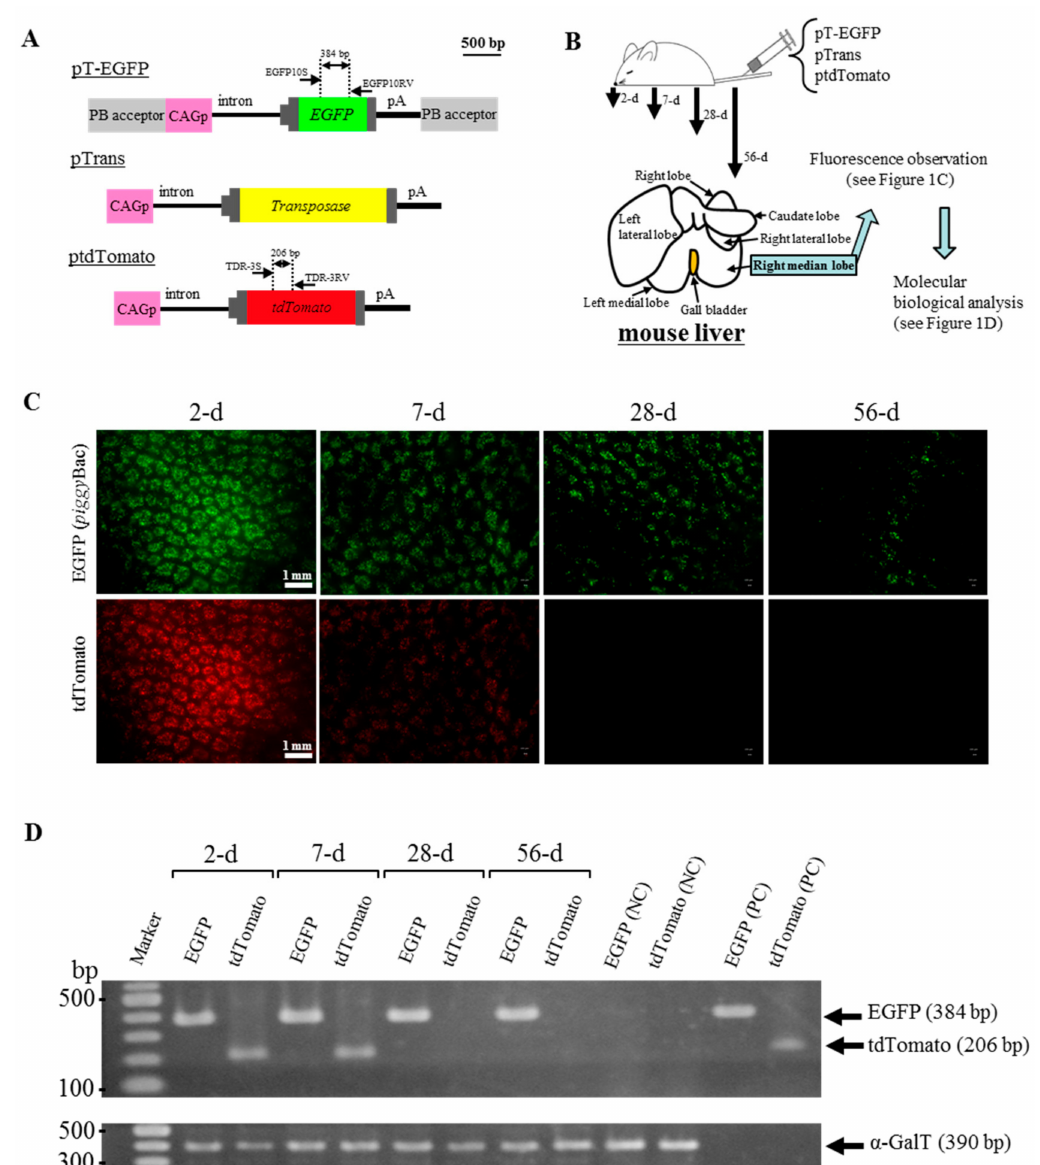
Figure 1. Hydrodynamics-based gene delivery and PB transposon system enable long-term gene expression in murine liver. ( A ) Structure of plasmid vectors used. The position of primers is shown above each plasmid. CAG, CMV enhancer + chicken β -actin promoter; intron, second intron of rabbit β -globin gene; EGFP, cDNA for enhanced green fluorescent protein; tdTomato, cDNA for tandem dimeric Tomato; pA, poly(A) sites; PB acceptor, acceptor site in PB system; ( B ) Schematic representation of experimental outline. Two PB-related plasmids (pT-EGFP and pTrans) and a non-PB plasmid ptdTomato are injected into adult ICR male mice via the tail vein by HGD. On 2, 7, 28, and 56 days after gene delivery, right median lobe of the liver is dissected for fluorescence observation and molecular biological analyses; ( C ) Fluorescent images of the right median lobe of the liver dissected 2, 7, 28, and 56 days (d) after gene delivery. tdTomato-derived fluorescence was observable on the specimens 2 to 7 days after gene delivery, whereas EGFP-derived fluorescence was still observed on the specimens 28 to 56 days after it; ( D ) PCR analysis of genomic DNA isolated from the right median lobe of a liver dissected 2, 7, 28, and 56 days (d) after gene delivery. The same amounts of genomic DNA were PCR-amplified using primers for detection of the endogenous α -GalT gene and used as internal controls. Negative control (NC), genomic DNA from intact mouse tail used as a negative control; Positive control (PC), plasmids pT-EGFP and ptdTomato (5 ng) used as positive controls for EGFP and tdTomato